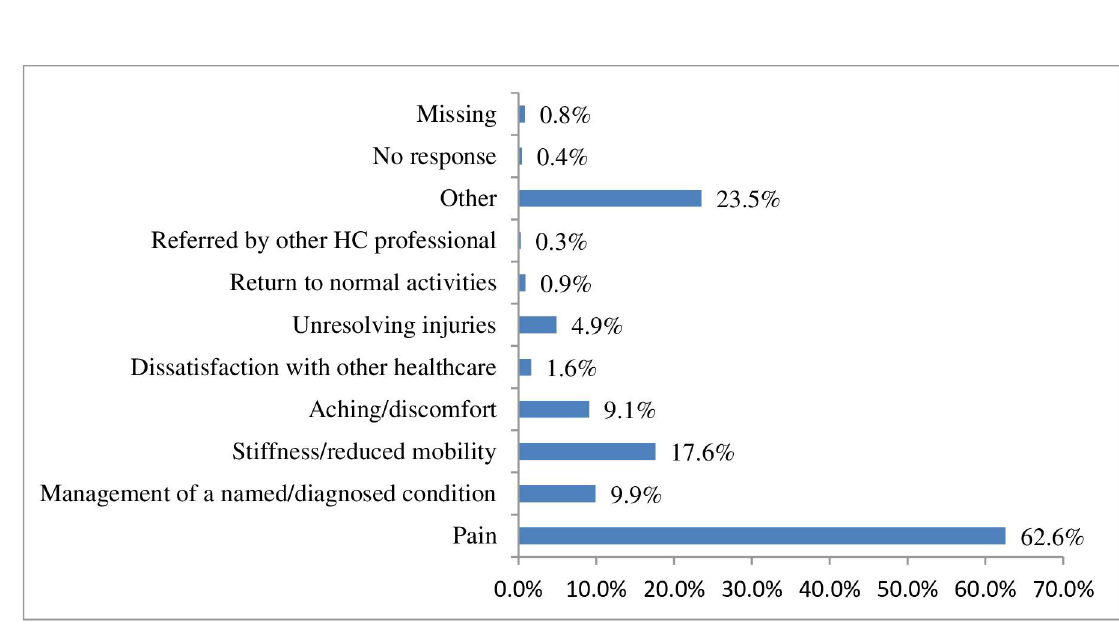
Fig 2. Reasons for seeking treatment.